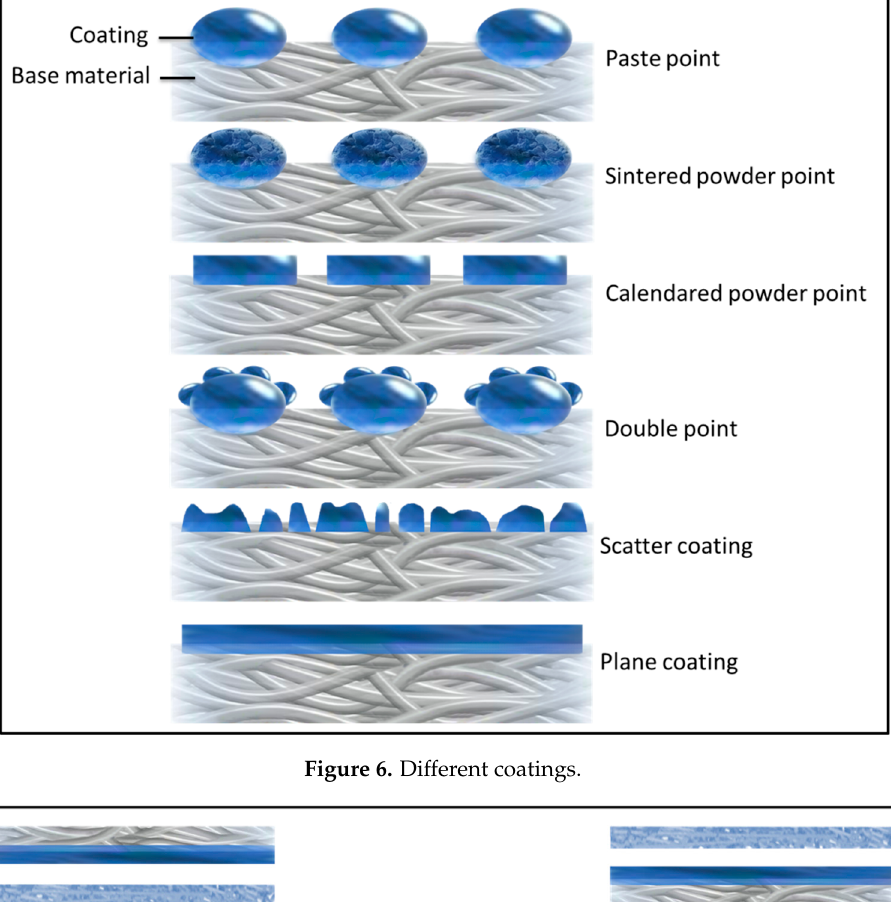
Figure 6. Different coatings.